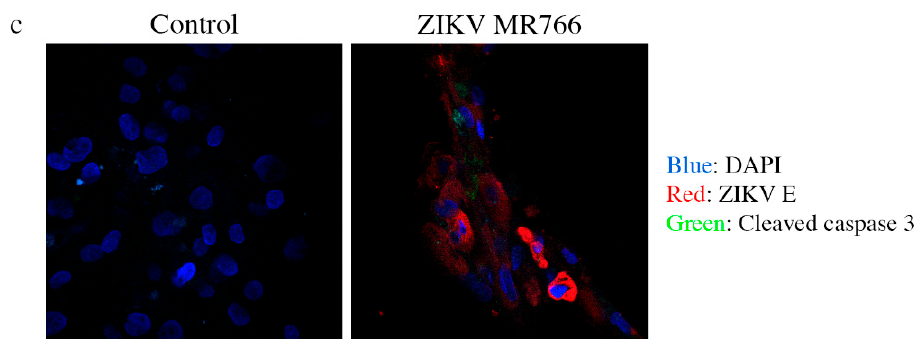
Figure 5. Analysis of continued cell death in ZIKV-infected testicular cells. ( a ) Cell count graph showing that there were 2-times more cells in the uninfected Hs1.Tes control, compared to ZIKV Paraiba-infected Hs1.Tes cells at P1. For both control and ZIKV-infected cells, the count was done after 7 days of cell passage. ****, p < 0.0001 (unpaired t -test). ( b ) Microscopic images showing loss of the Hs1.Tes monolayer in ZIKV-infected cells at P3. The morphology of infected cells at this time point appeared grossly aberrant and pleomorphic when compared to that of uninfected control cells. Cells were imaged at a magnification of 400 × . ( c ) Confocal microscopy images showing cleaved caspase 3 in some ZIKV-infected Sertoli cells at P1. Not all ZIKV E protein-expressing cells stained positive for cleaved caspase 3, supporting the notion that cell death in persistently infected cells was progressive. Cells were imaged at a magnification of 400 ×